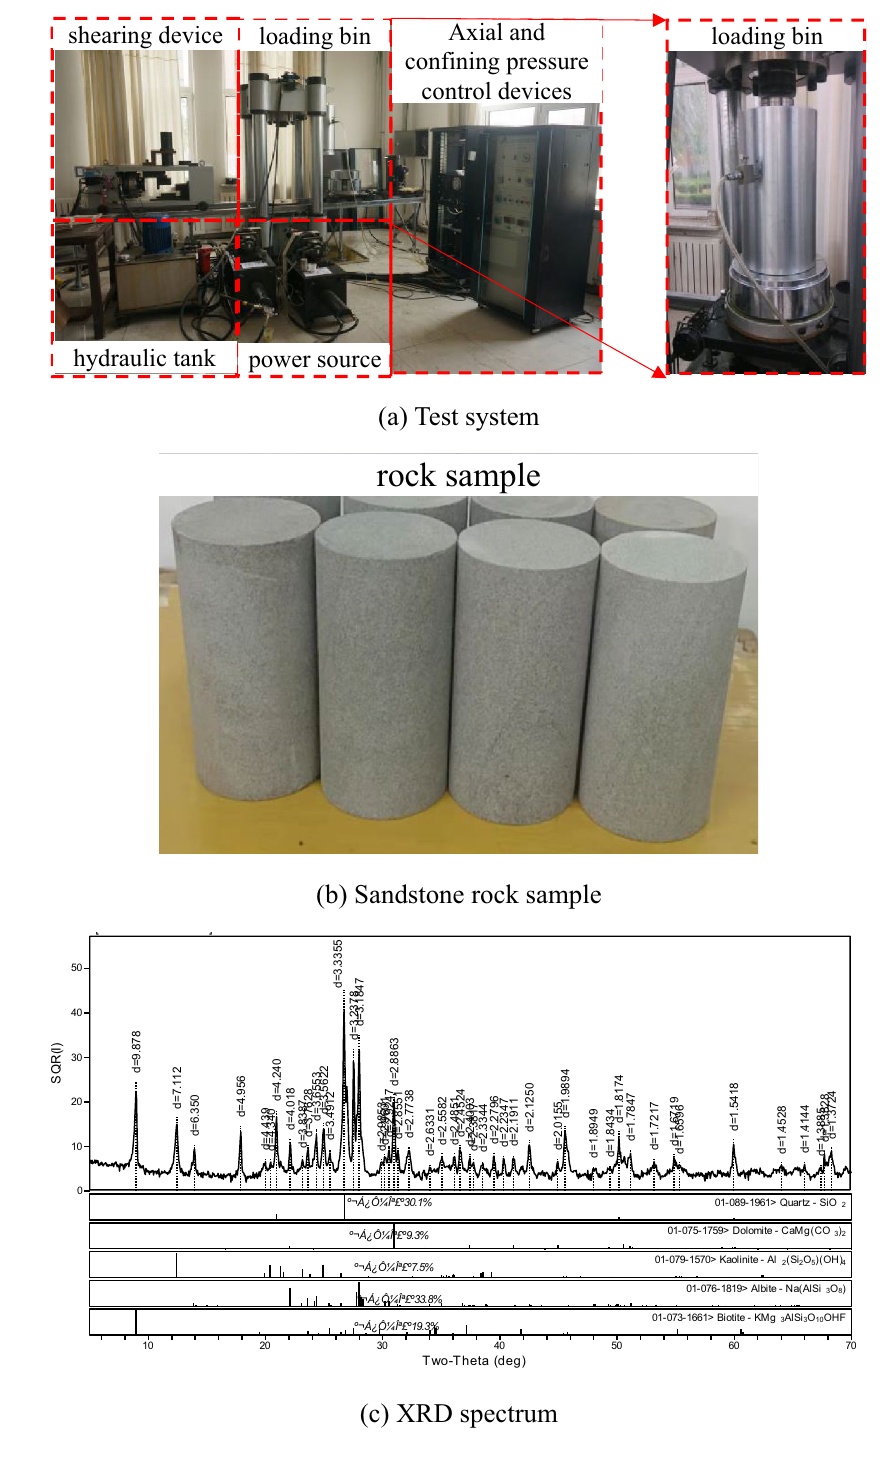
Figure 4. Rock mechanics test system and sandstone rock